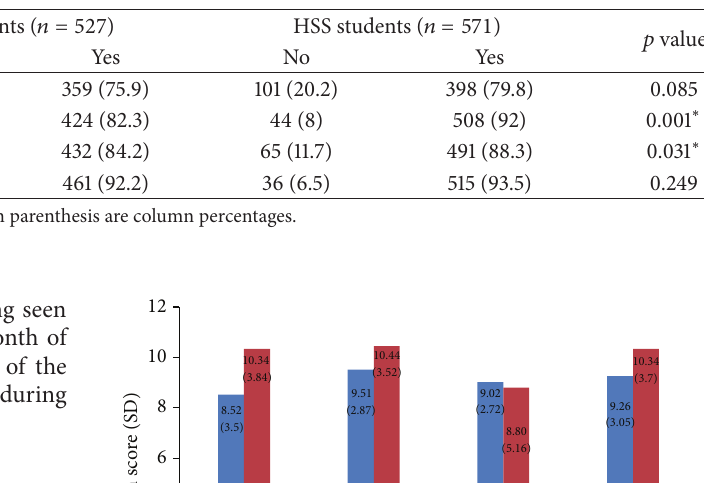
Table 4: Student’s knowledge and attitude on tobacco hazards.